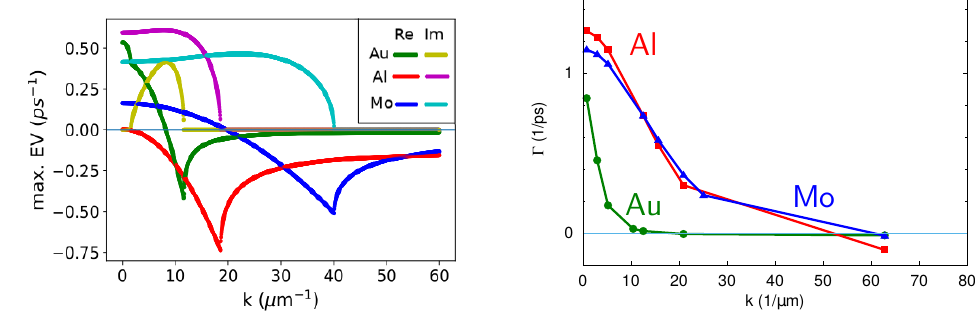
Figure 7. ( Left ) real and imaginary parts of the maximal eigenvalues (EV) of the matrix A , corresponding to the growth rates estimated in the analytical model. Calculations are made for Al ( ξ = 9.0 × 10 6 m − 1 ), Mo ( ξ = 1.56 × 10 7 m − 1 ), and Au ( ξ = 5.9 × 10 6 m − 1 ). ( Right ) numerically calculated growth rates for the time interval between t 0 and t c